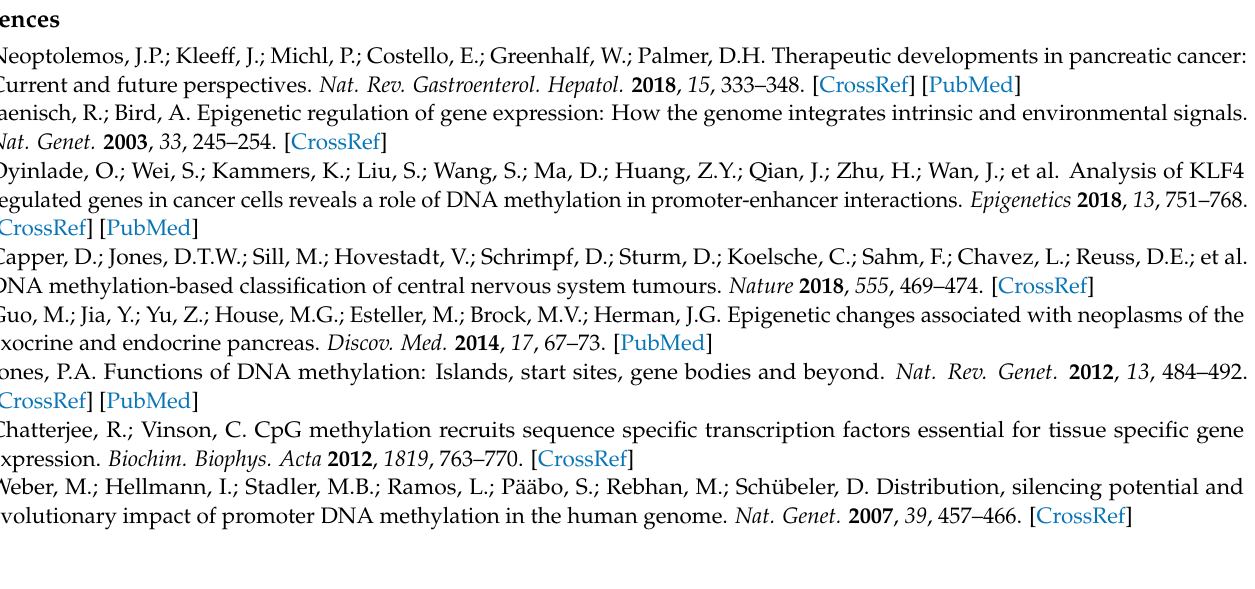
Table S4: Western blot